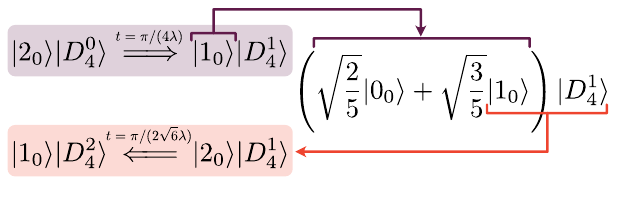
√ (cid:2) + 3 / 5 ) | 1 0 (cid:2)| D 2 4